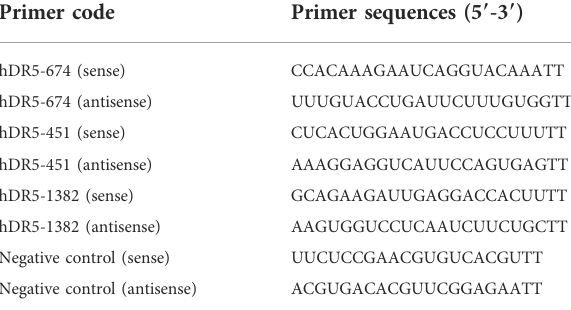
TABLE 2 List of small interfering RNA sequences for silencing DR5. Primer